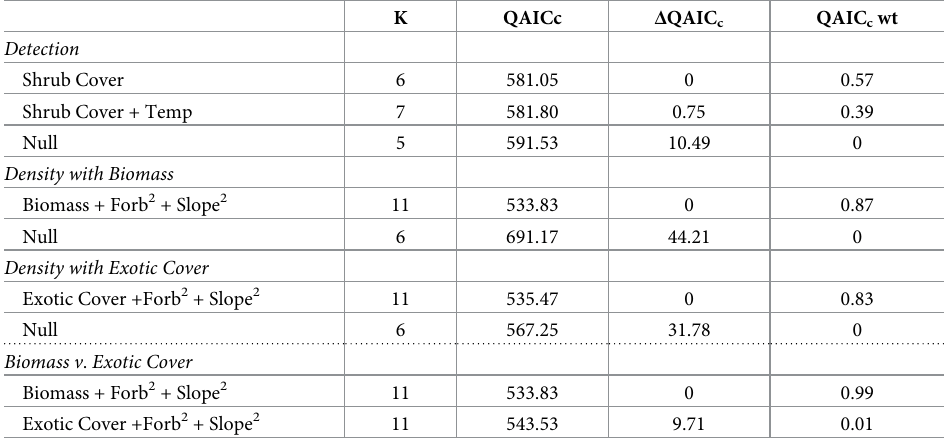
Table 1. Model selection table for nest detection probability and nest density of chestnut-collared longspurs from 272 rope drag surveys of 100 9-ha plots in Phillips County, MT during May–June of 2017 and